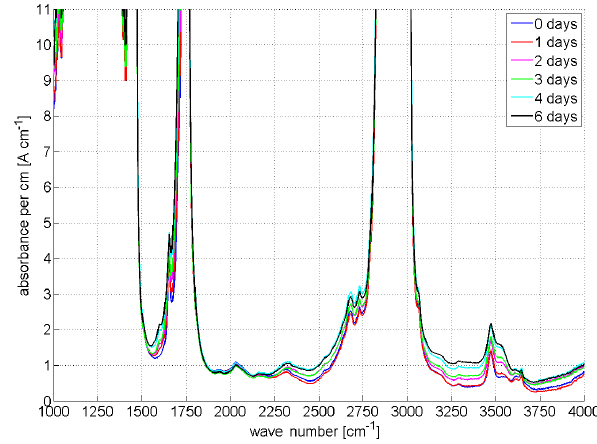
Figure 7. IR spectrum of ester-based hydraulic fluid (1500mL) ar- tificially aged at 130 ◦ C with 50cm 3 min − 1 air flow over 6 days.